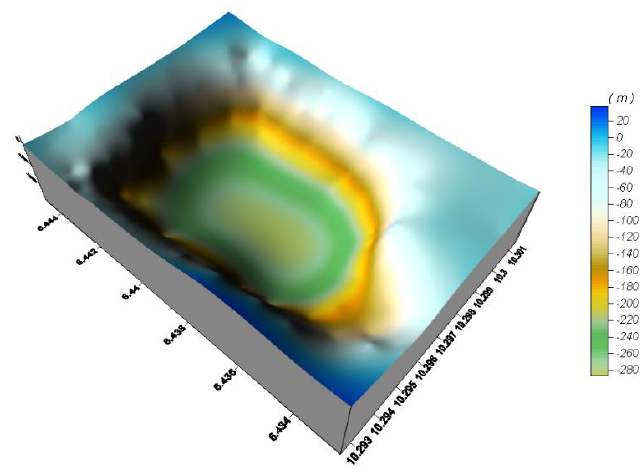
Figure 2. Three-dimensional digital terrain bathymetry of Lake Nyos showing its rectangular shape (computed from Surfer Software with bathymetric contours from Hassert, 1912 [18]).